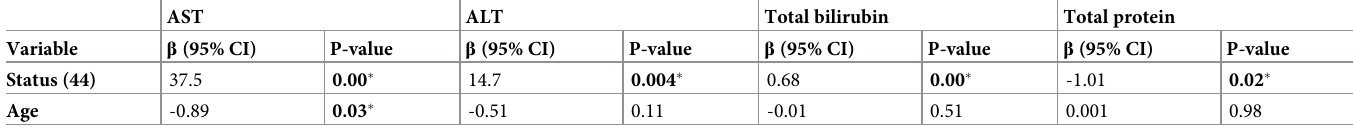
= statistically significant at P < 0.05).